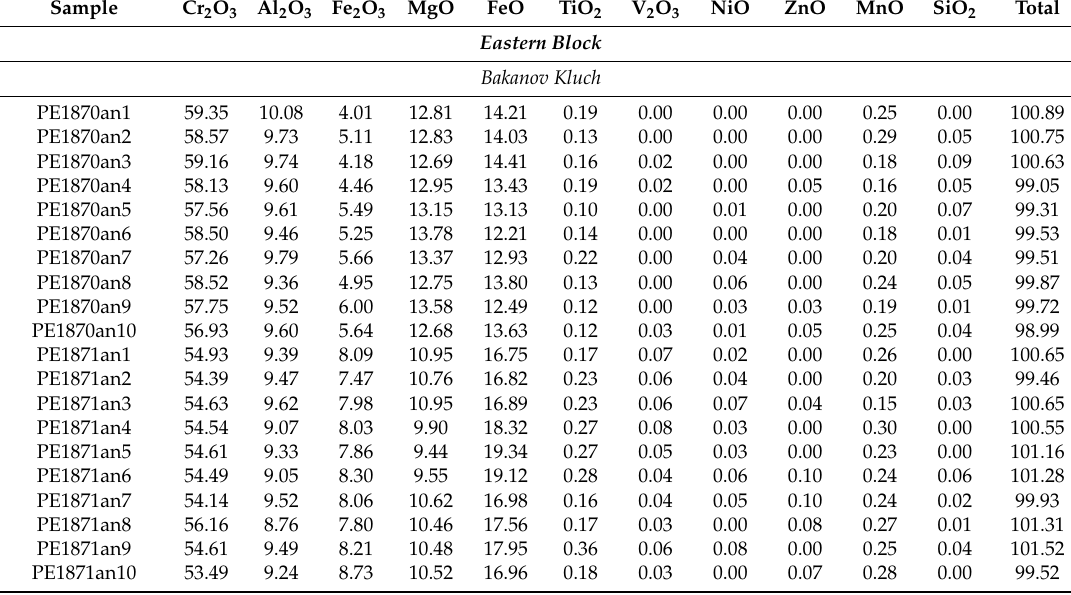
Table A1. Representative electron microprobe analyses (wt %) of chromite from chromitites of Alapaevsk.